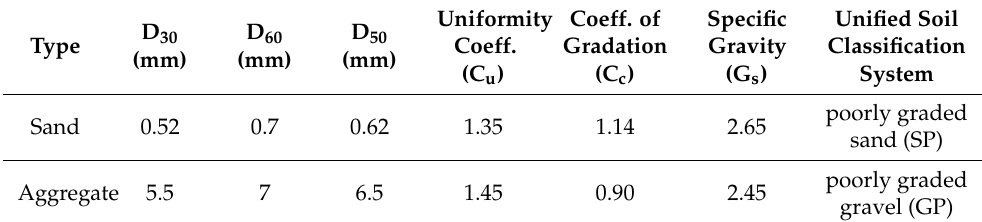
Figure 3. Stemming materials for Trauzl test and general stemming material particle size distributions. Table 1. Properties of general stemming materials.